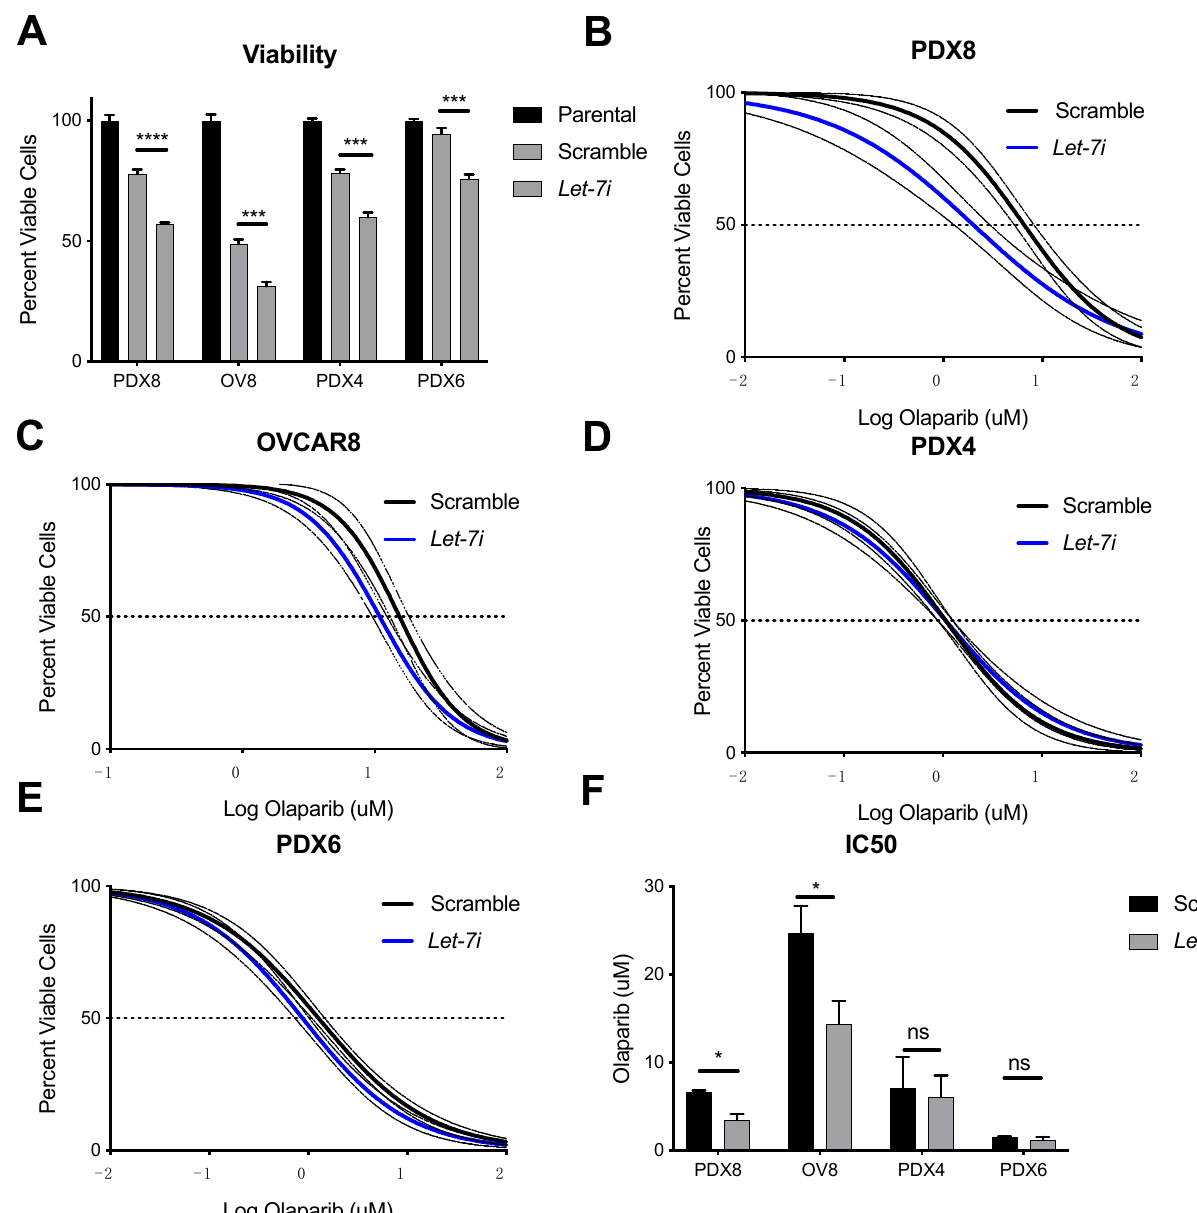
Figure 4. Let-7i effect on cancer cell viability and sensitivity to olaparib. Let-7i up-regulation resulted in reduced cell viability ( A ) and sensitivity to olaparib in HR competent samples ( B , C ). There was no effect on olaparib resistance in samples with BRCA1/2 mutation ( D , E ). ( F ) demonstrates IC50. N = 3+ independent replicates. Student’s t test was used for statistical analysis. Error bars: SEM. * p ≤ 0.05, *** p ≤ 0.001, **** p ≤ 0.0001. p value ≤ 0.05 was considered significant. ns, not significant.